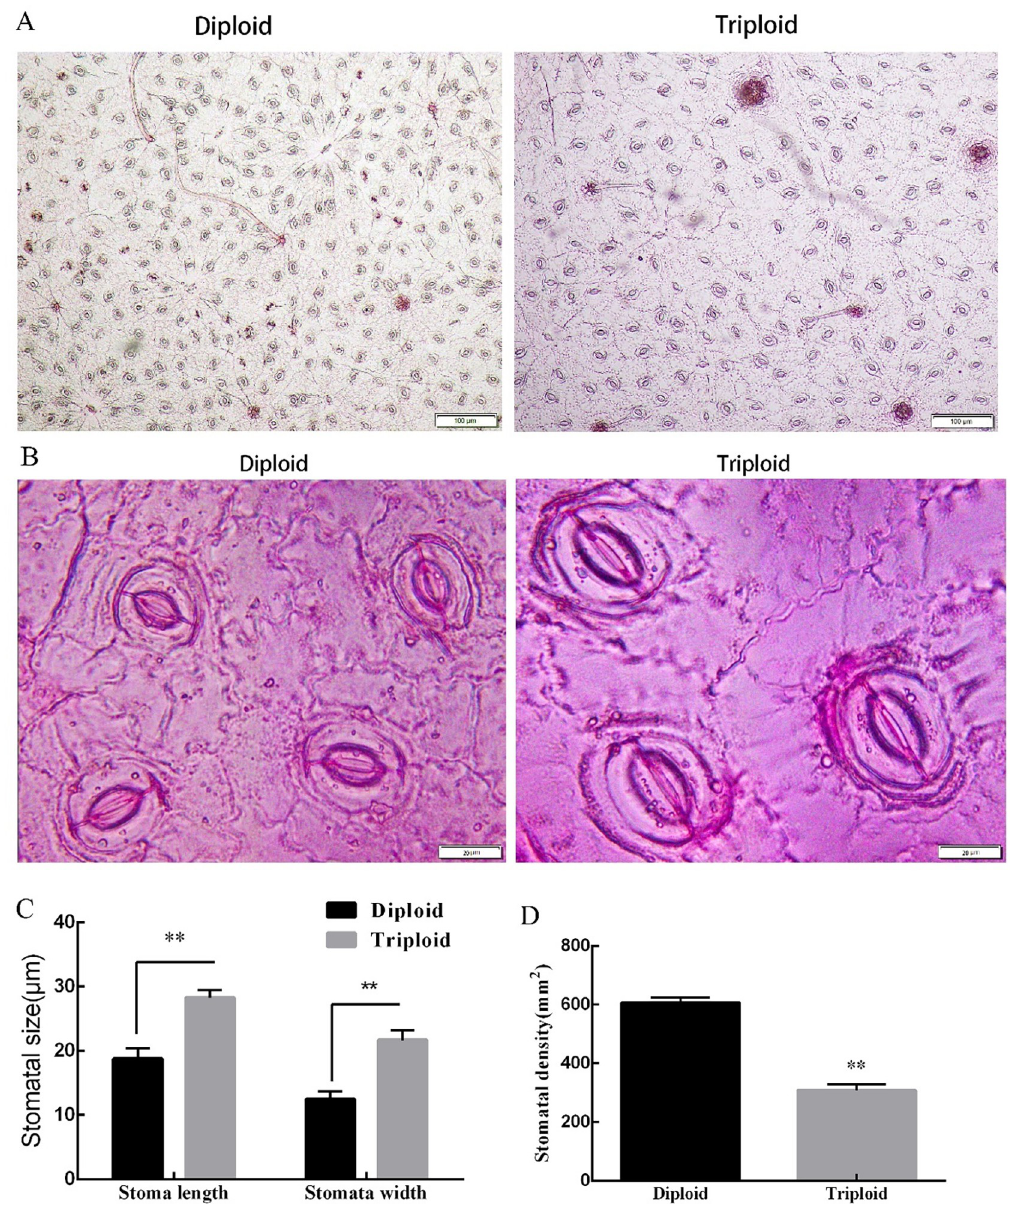
Fig 1. Number of stomata in diploid and triploid tea leaves. A: Number of diploid stomata and triploid stomata at 100X magnification; B: Number of diploid stomata and triploid stomata at 1000X magnification; C: Length and width of diploid and triploid stomata; D: Diploid and triploid stomatal density in the same field of view. Error bars indicate SD (n = 3); statistical significance is indicated � P < 0.05, �� P < 0.01.